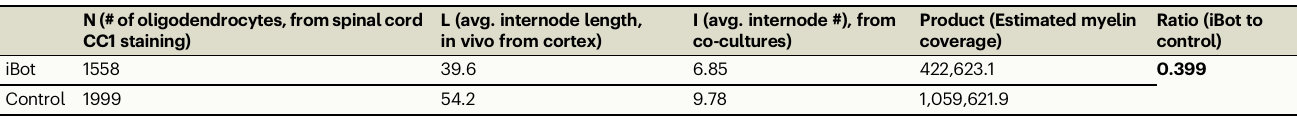
Table 1 | Calculation for relative myelin coverage by internode analysis (iBot to WT) N(#ofoligodendrocytes,fromspinalcord CC1 staining)